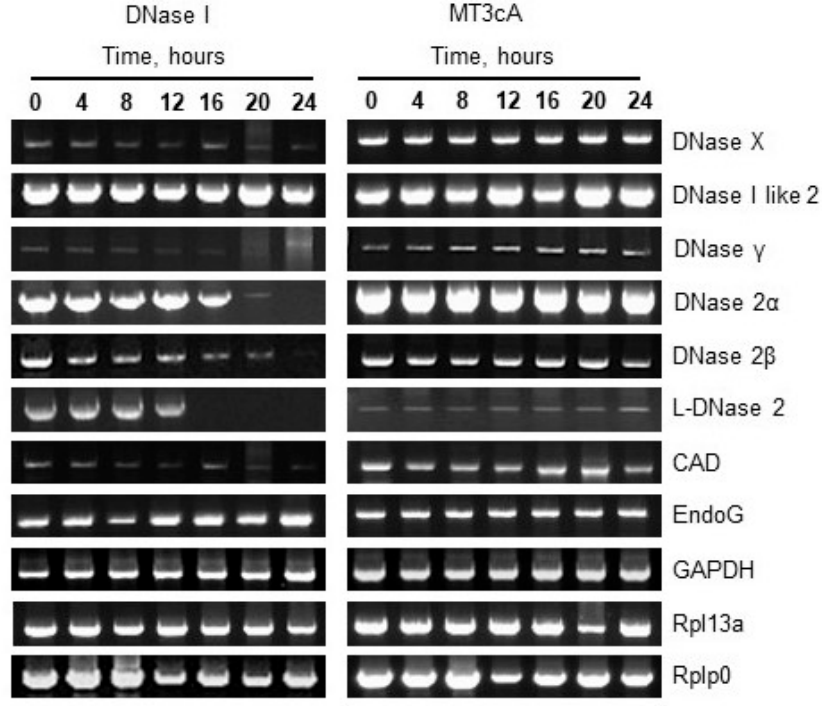
Figure 5. DNase I overexpression induces breaks in the promoter / exon 1 regions of endonucleases genes. PCRs of genomic DNA in promoter/exon 1 regions of endonucleases and housekeeping genes genes. PCRs of genomic DNA in promoter / exon 1 regions of endonucleases and housekeeping genes (GAPDH, PPL13a, and Rplp0) were performed using primers listed in Table S1. (GAPDH, PPL13a, and Rplp0) were performed using primers listed in Table